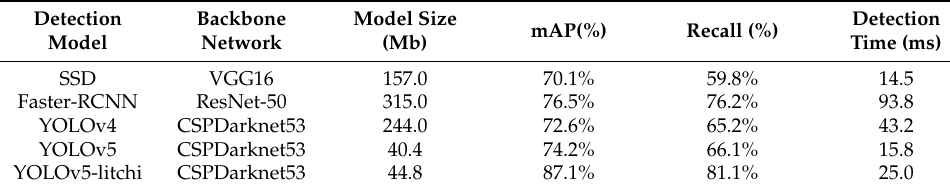
Table 3. Comparison of five detection